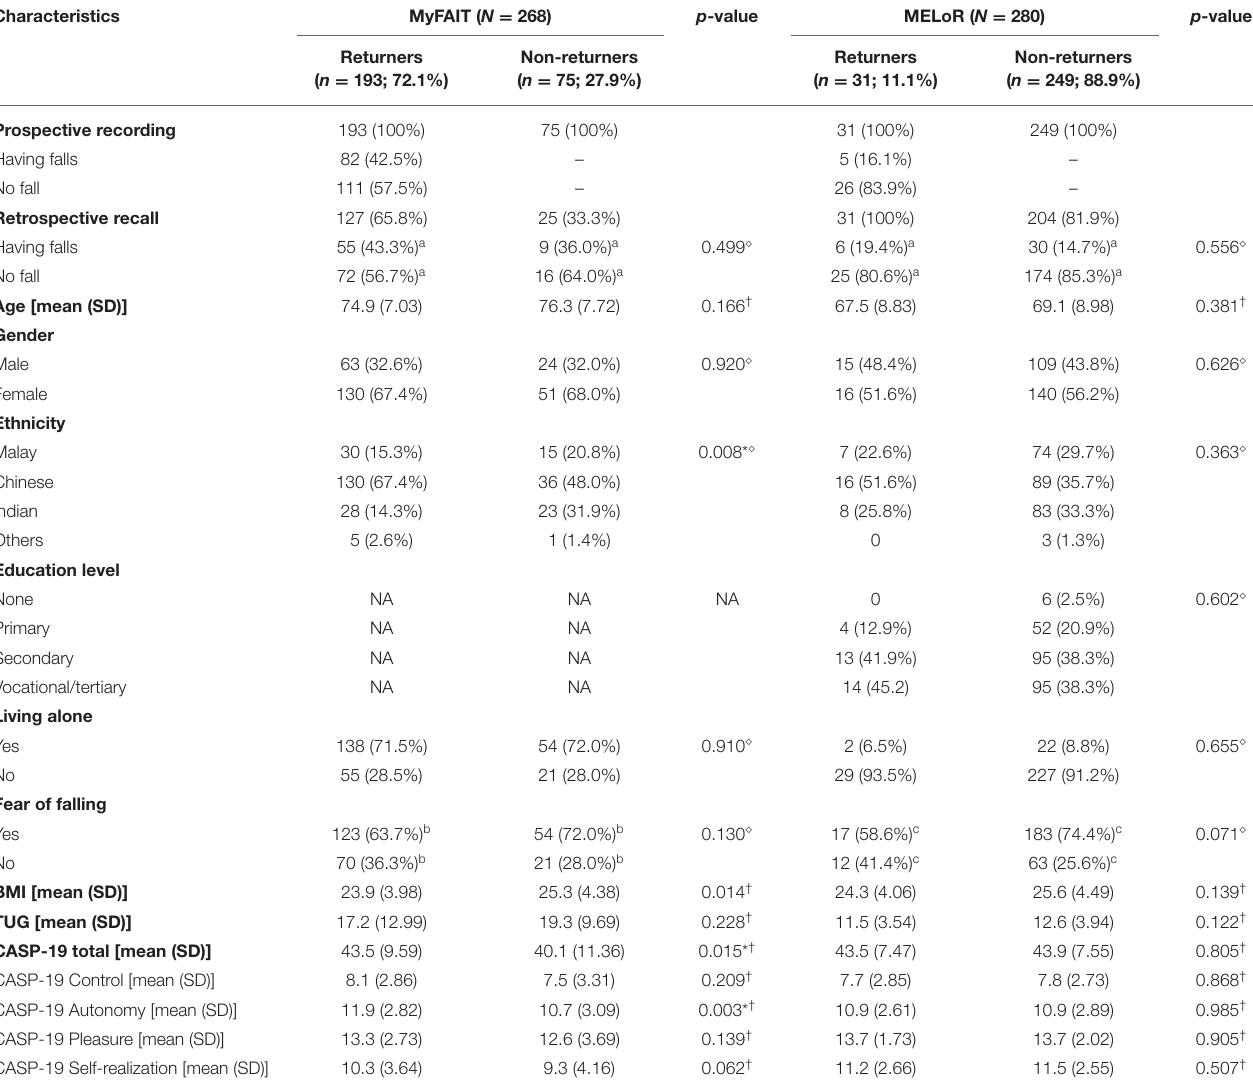
TABLE 1 | Characteristics of the returners and non-returners of prospective recordings.